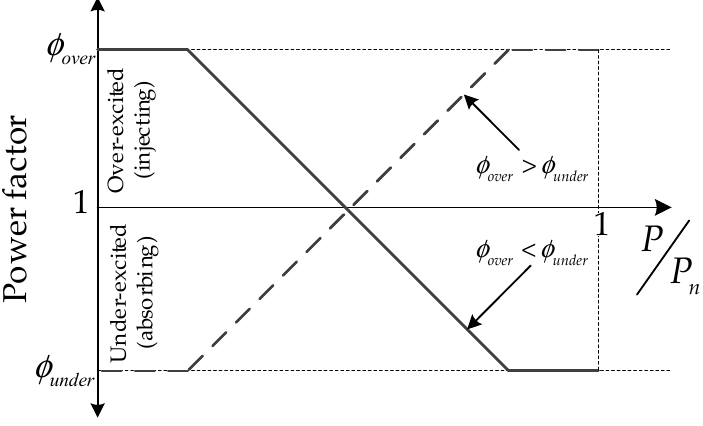
Figure 3. Smart inverter control based on ϕ ( P ) − characteristic.